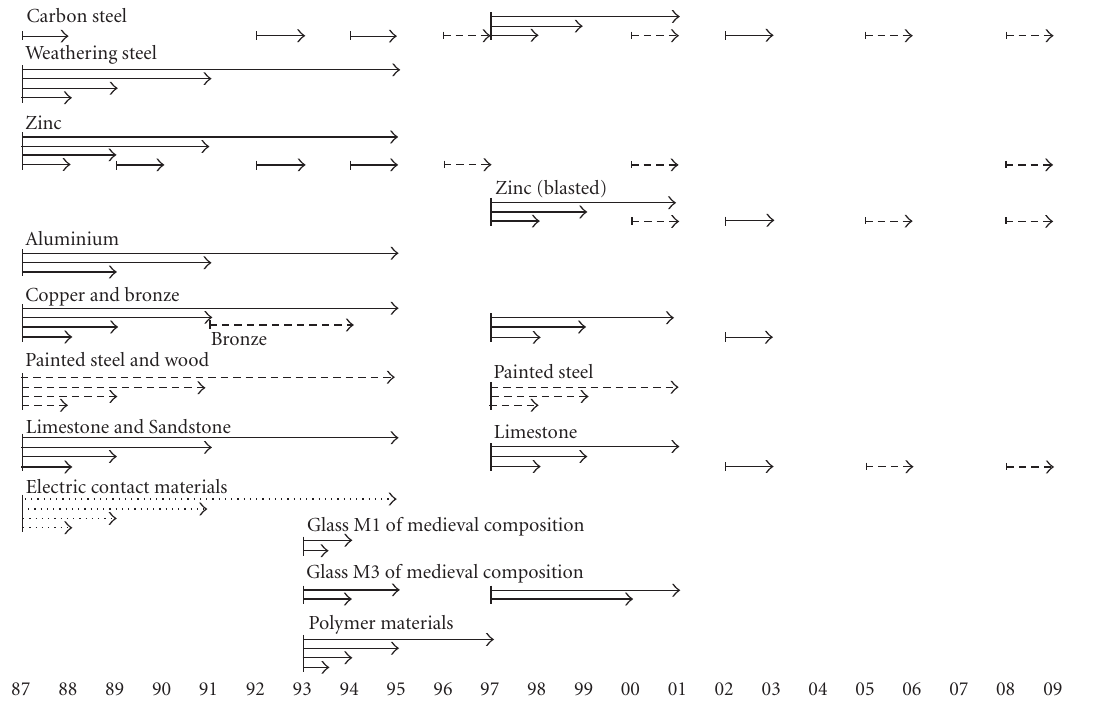
Figure 1: Overview of performed corrosion exposures within ICP Materials (solid arrows: unsheltered and sheltered exposure; dashed arrows: unsheltered exposure; dotted arrows: sheltered exposure inside an aluminium